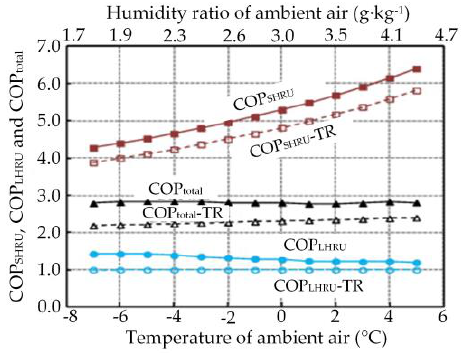
Figure 23. Comparison of COP total between FFASHP system and tradition heat pump system [84].